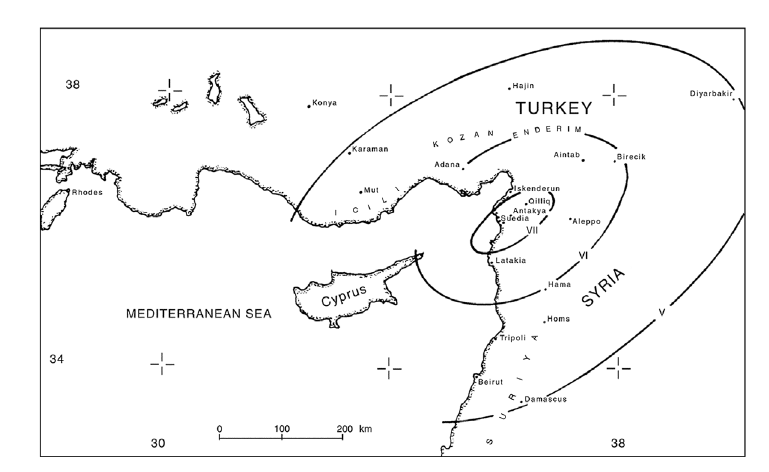
Fig. 18. Map of intensity distribution for April 3, 1872 earthquake (Ambraseys, 1989).